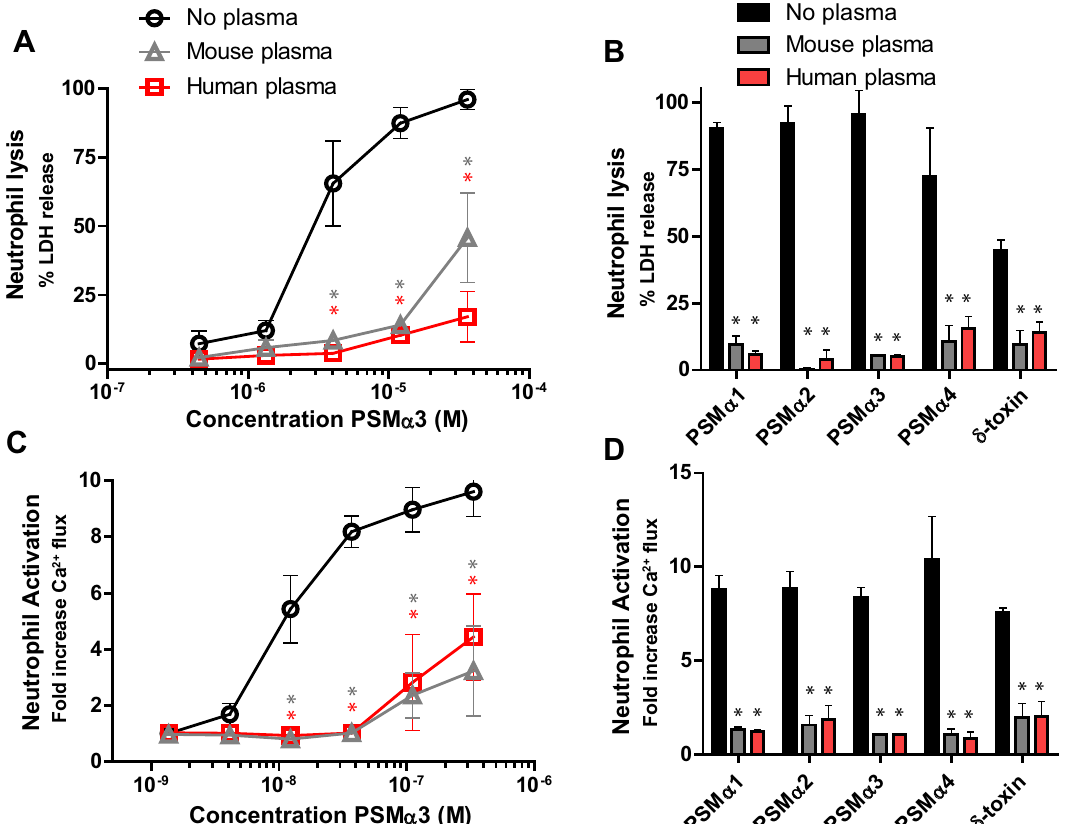
Figure 1. Human and murine control plasma inhibit PSM-mediated neutrophil lysis and activation. ( A ) Dose- dependent neutrophil lysis by synthetic PSMα3 (400 nM to 30 µM), preincubated with or without 1% human or murine plasma. ( B ) Neutrophil lysis by synthetic PSMα1-3 (10 µM), PSMα4 and δ-toxin (50 µM) pretreated with or without 1% human or mouse plasma. Neutrophil lysis was measured through LDH release. ( C ) Dose– response curves for calcium mobilization in HL-60/FPR2 cells induced by PSMα3 with 0.1% human or mouse plasma-treated PSMα3. ( D ) Calcium mobilization of HL-60/FPR2 stimulated with 50 nM PSMα1, 500 nM PSMα2, 50 nM PSMα3, 5 µM PSMα4, and 200 nM δ-toxin, all pre-incubated with or without 0.1% human or mice plasma, before calcium mobilization was measured by flow cytometry. Red and gray * indicates statistical significance of p < 0.01 to no plasma conditions. Data represent means ± SEM of 3–5 independent experiments. One-way